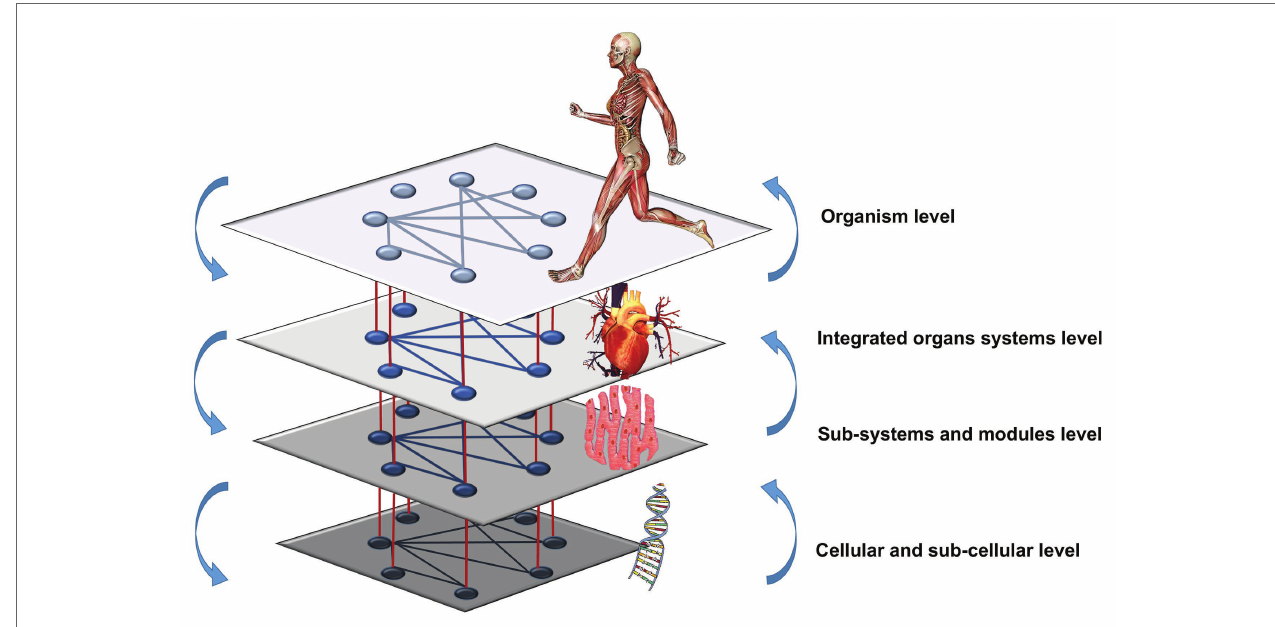
FIGURE 1 | Schematic diagram for the vision on Network Physiology of Exercise. Hierarchically organized physiological network levels interact both horizontally and vertically through circular